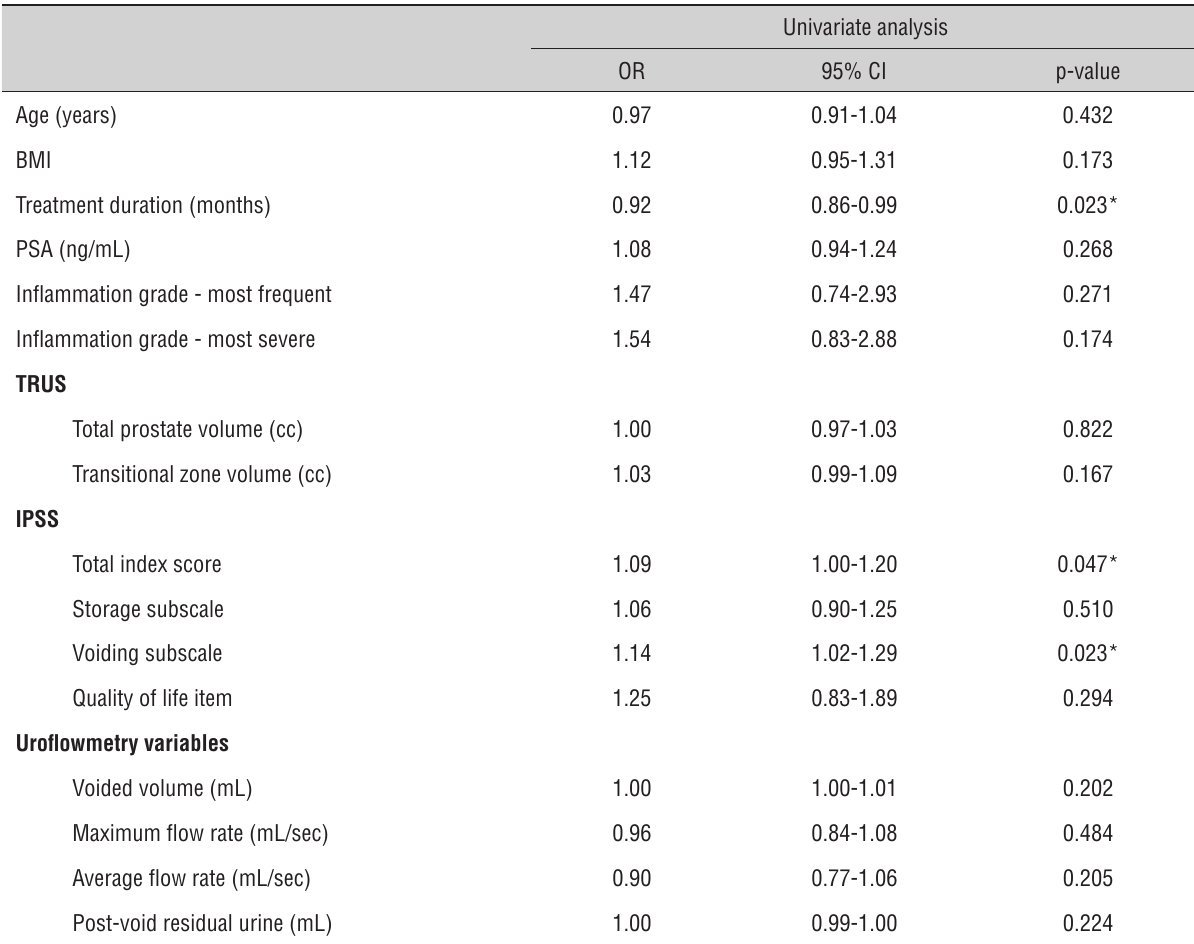
Table 5 - Predictive factors of symptomatic improvement after alpha blocker therapy on univariate